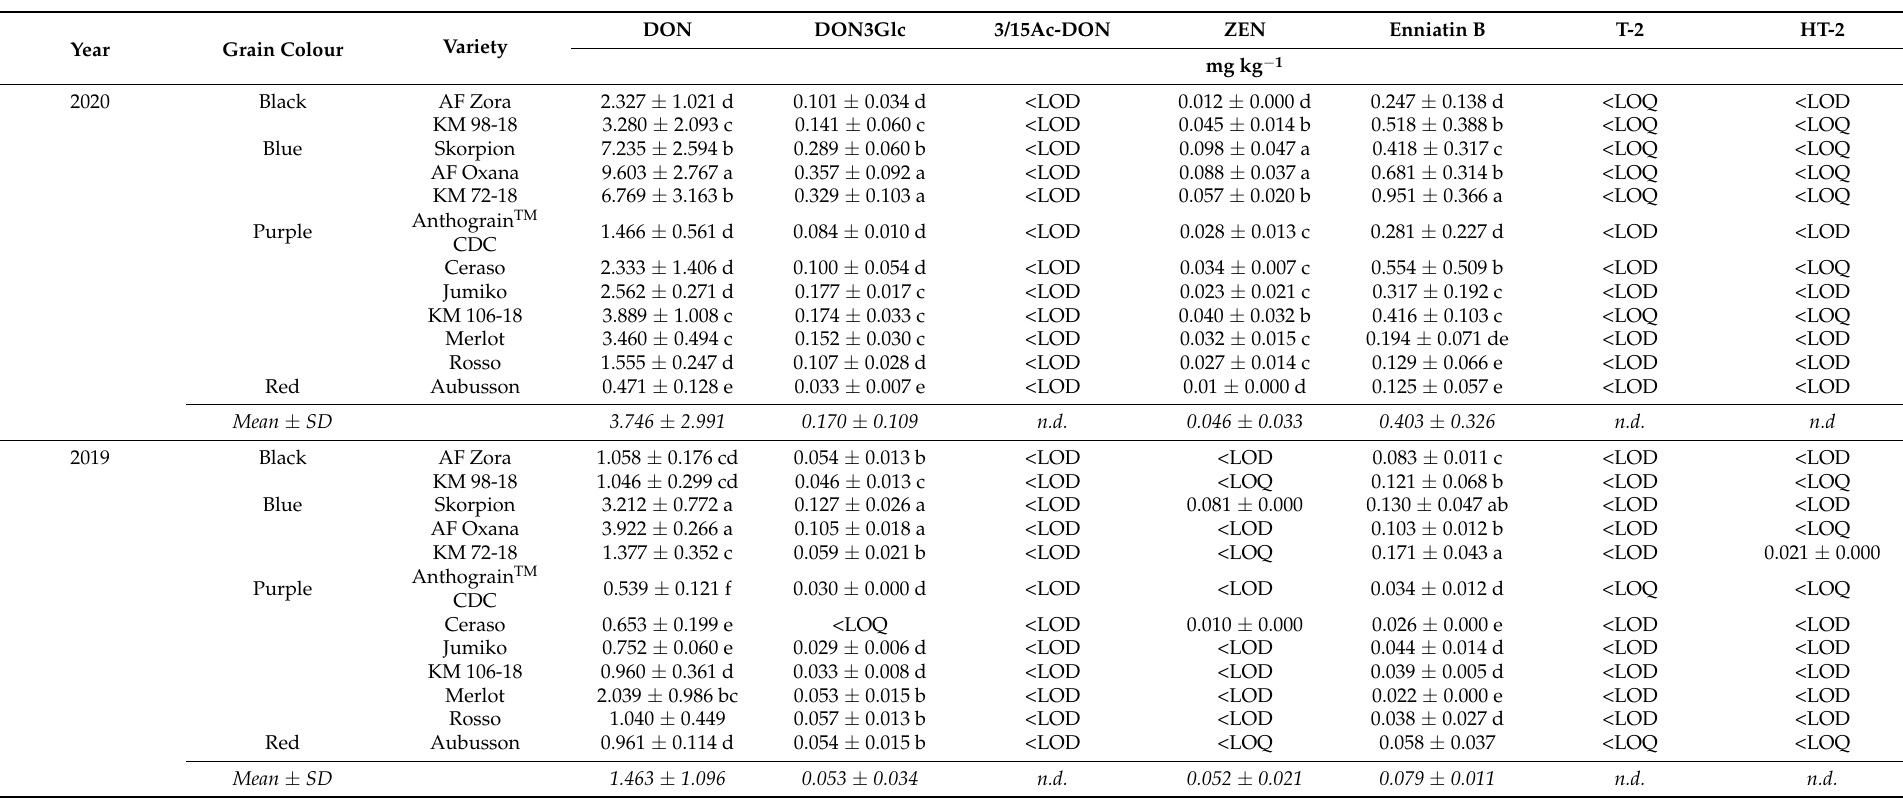
Table 3. Occurrence of mycotoxins in twelve varieties of coloured common wheat. Three biological replicates and three technical replicates were considered for each variety. Data are reported as means ± SD. Different letters indicate significant differences ( p < 0.005) among varieties within the same harvest